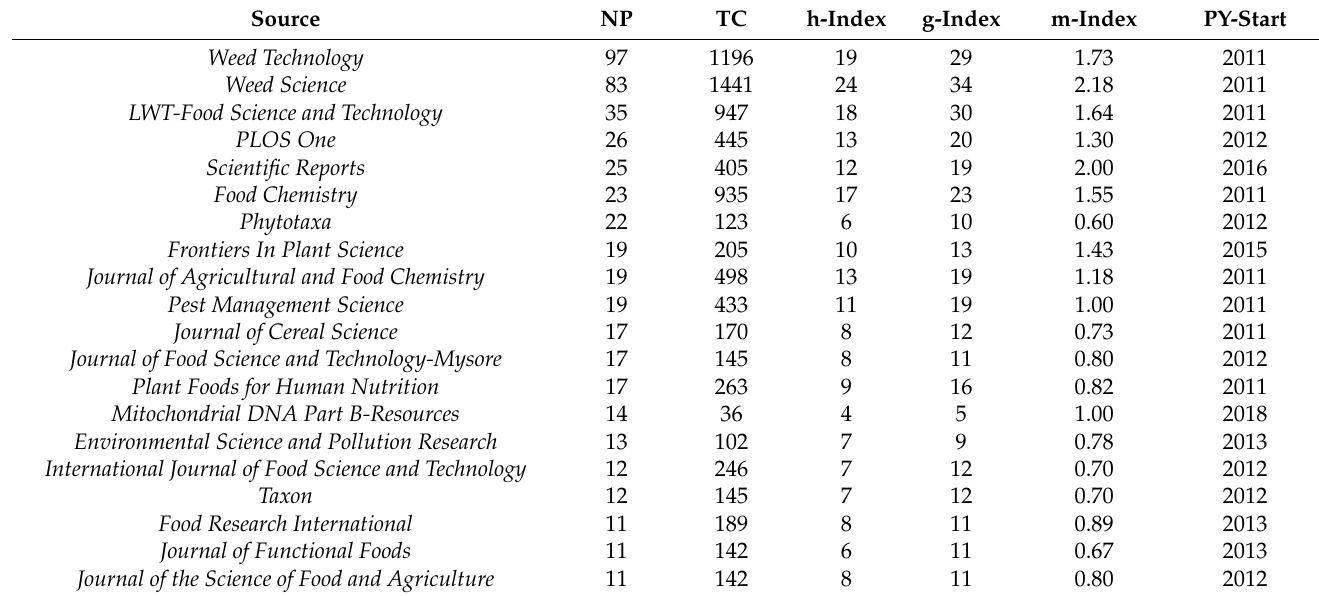
Table 4. Twenty of the top-most journals in amaranth-related research from 2011 to